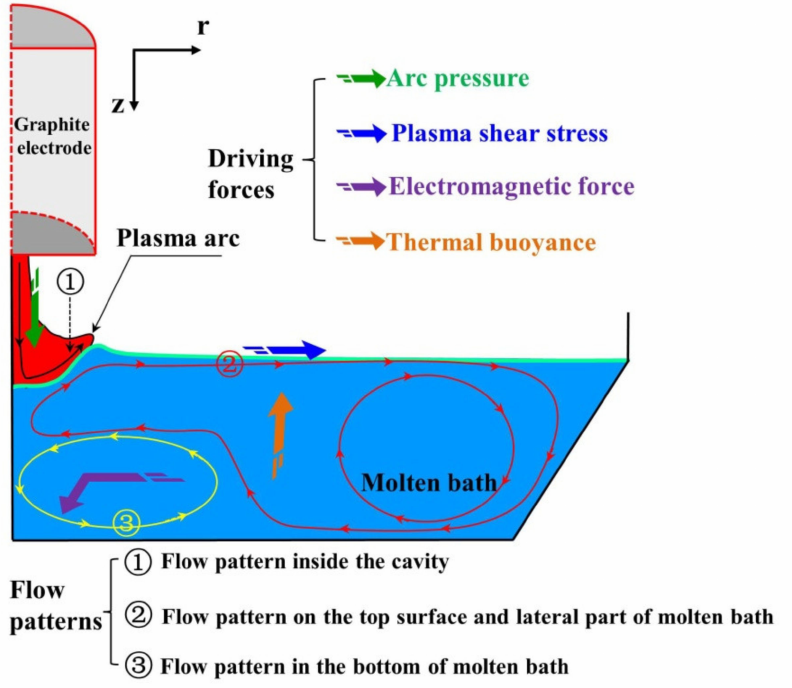
Figure 9. Schematic illustration of the main driving forces and flow patterns of the molten